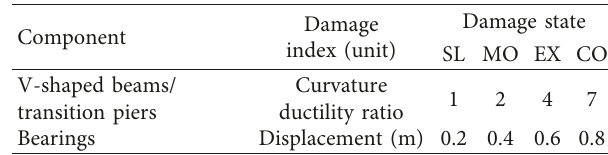
Table 4: Description of bridge damage. Table 5: Damage index under different damage